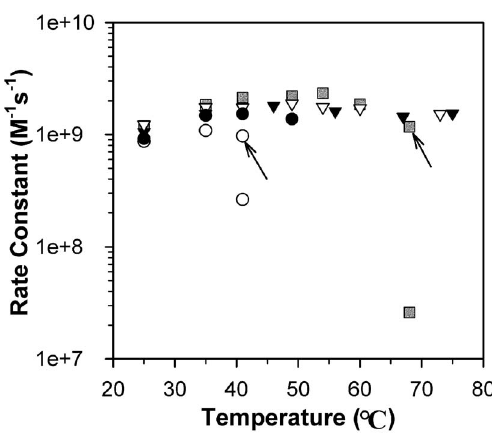
Figure 4. RP-mutant Ca MnSODc is more subject to inactivation by pH than the wild type. Rate constants as a function of pH were determined by fitting the disappearances of low doses of O 2 2 ([O 2 2 ]:[MnSOD] from 1–3) to first-order processes. The enzymes were WT Sc MnSOD (solid triangle), K182R, A183P Sc MnSOD (hollow triangle), WT Ca MnSODc (solid circle) and K184R, L185P Ca MnSODc (hollow circle). The data points circled and/or indicated with an arrow were measured after the pH was adjusted from 9–9.5 to neutral. The sample solutions contained 1 m M (in Mn) MnSOD in 10 mM potassium phosphate (pH 7), 10 mM sodium formate and 10 m M EDTA.